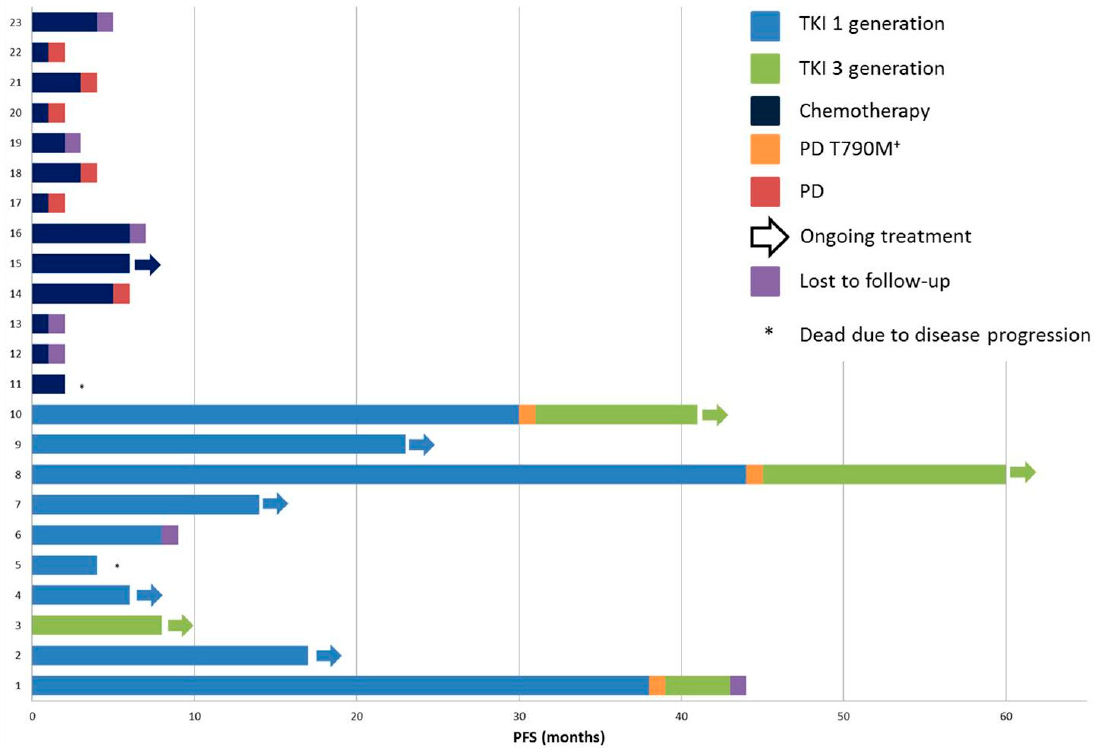
Figure 2. Progression-free survival (PFS) of patients actively treated with chemotherapy and tyrosine kinase inhibitors (TKIs).